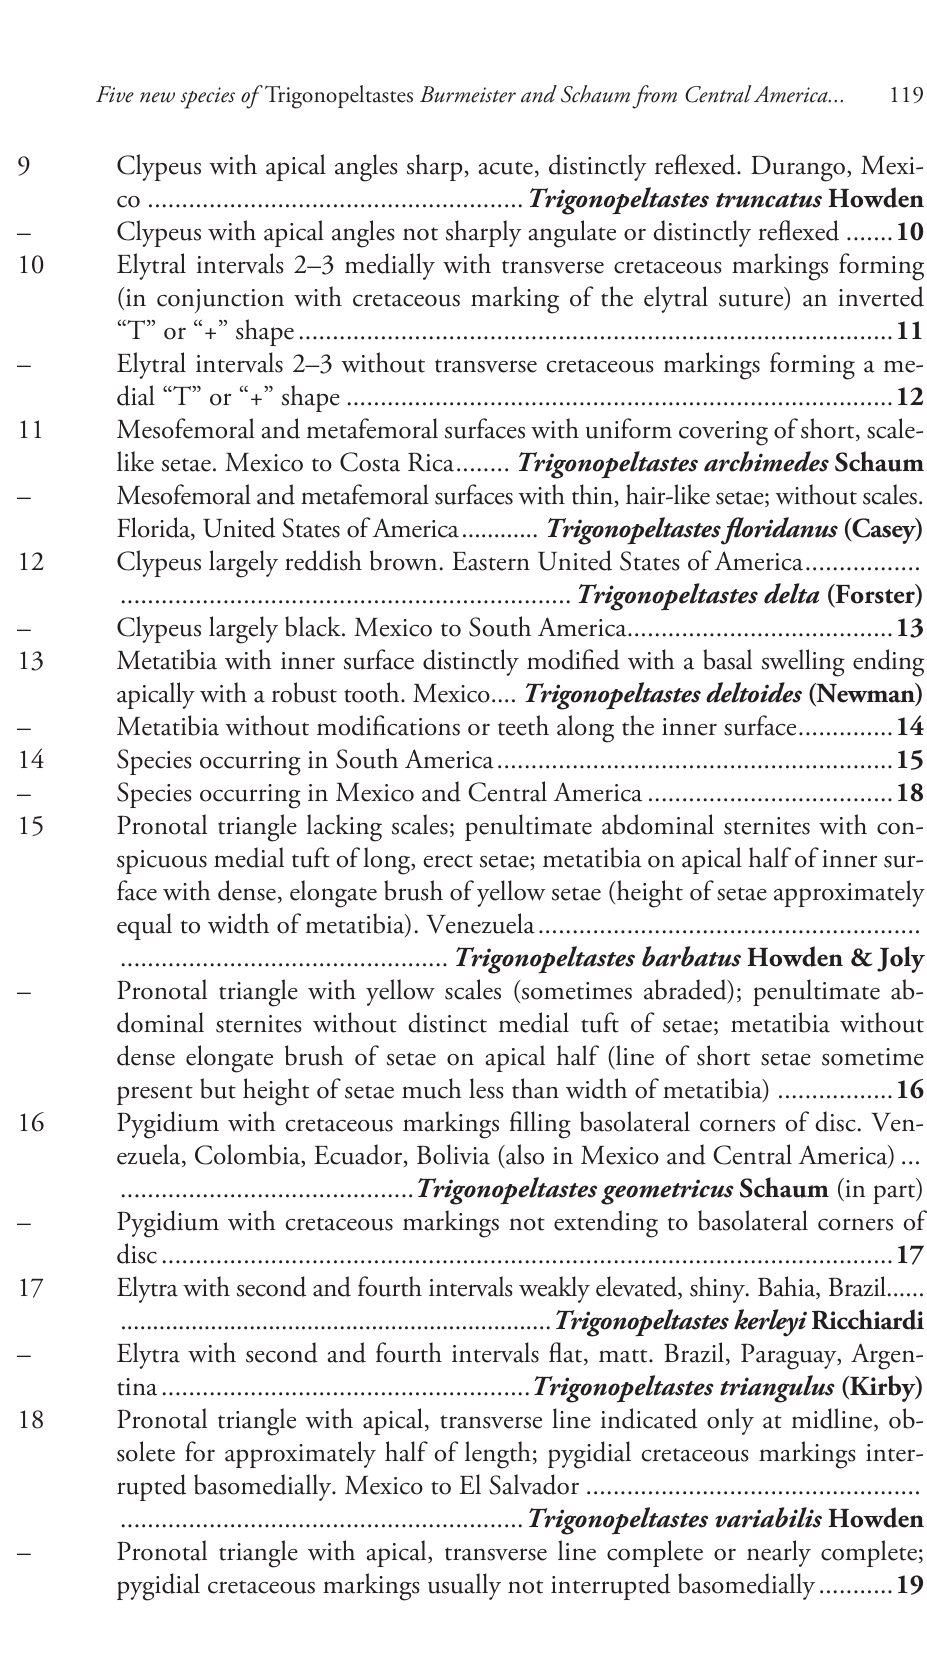
Elytra with second and fourth intervals flat, matt. Brazil, Paraguay, Argen- Pronotal triangle with apical, transverse line indicated only at midline, ob- solete for approximately half of length; pygidial cretaceous markings